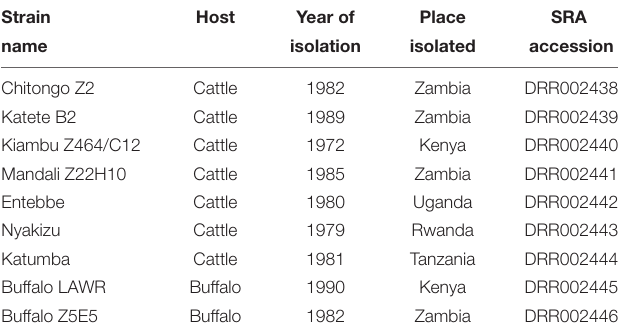
TABLE 2 | Eastern and southern African additional genomes used for the genetic diversity studies of Theileria parva *. Strain Host Year of Place